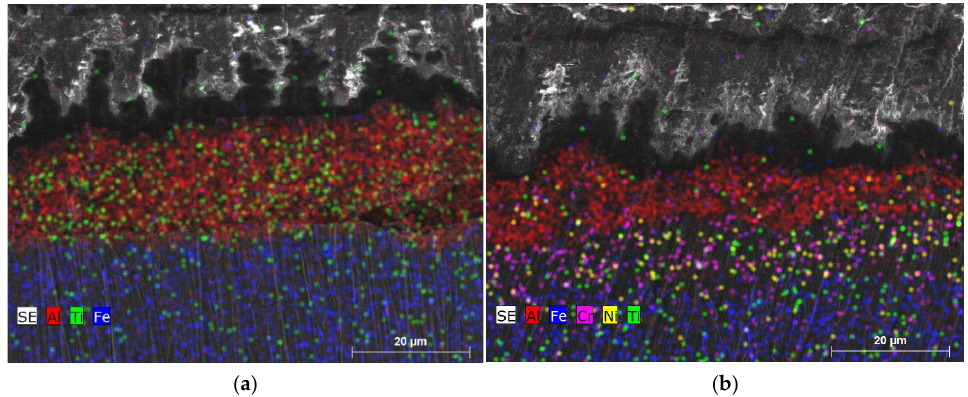
Figure 14. Elemental maps of Al 2 O 3 -13 wt.% TiO 2 coating cross-sections before ( a ) and after ( b ) 25 heat treatment cycles.